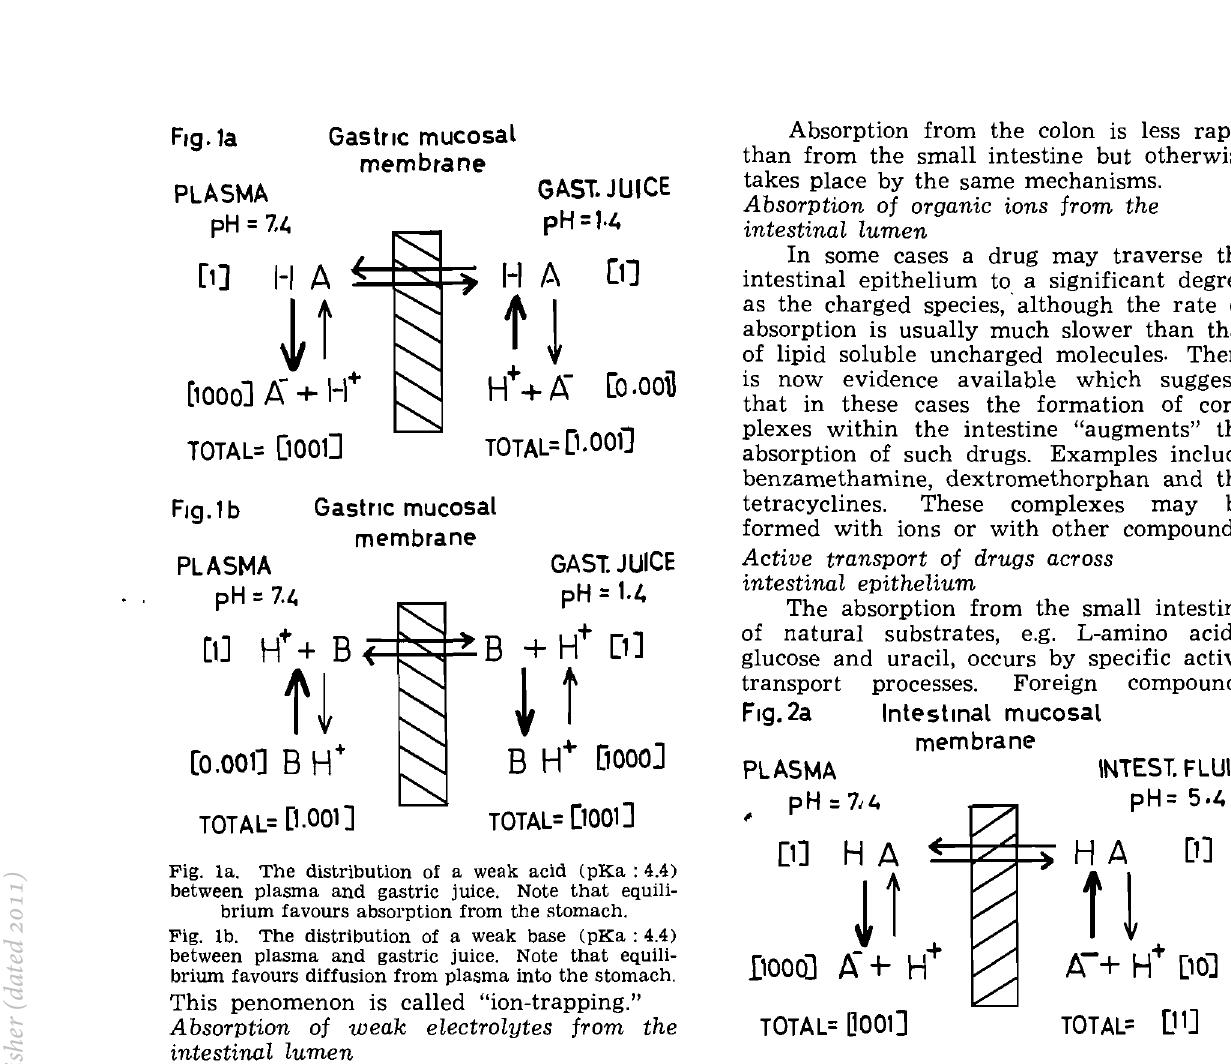
Fig. 2a. The distribution of a weak acid (pKa: 4.4) between plasma and intestinal fluid. Note that the equilibrium favours absorption from the intestine. Fig. 2b. The distribution of a weak base (pKa: 4.4) between plasma and intestinal